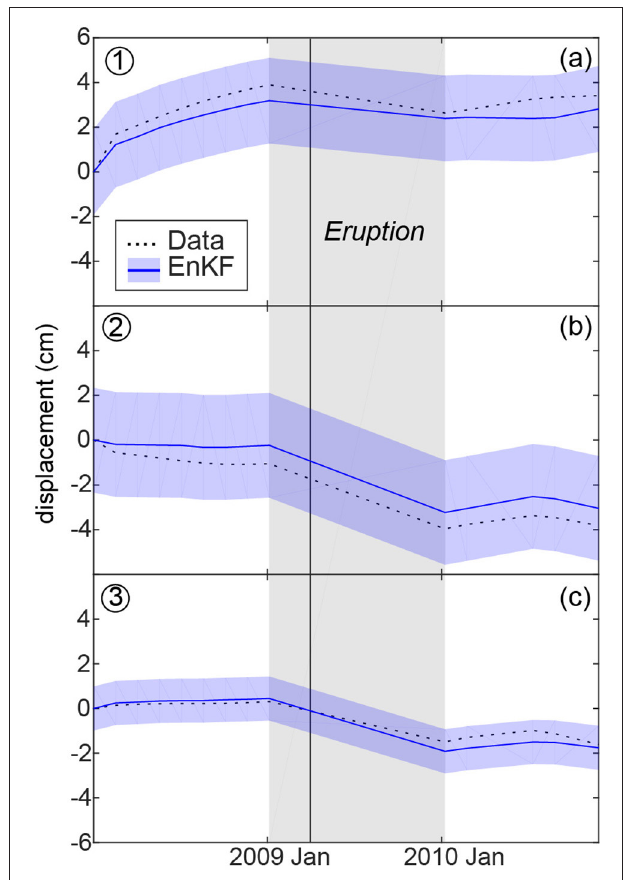
FIGURE 4 | 2008–2011 displacement measured by the InSAR time series (dash line) compared to the displacement produced by the best fit combined EnKF model (full line and filled blue area). The numbers at the left-top corners correspond to the sampling locations shown on Figure 1 . (a) Is the center of the volcano and (b,c) are the flanks. The blue shaded regions show the standard deviations of the ensembles. The black solid line indicates the time of the 2009/1/11 eruption of Kerinci, and the gray shaded region highlights the gap in SAR acquisitions.